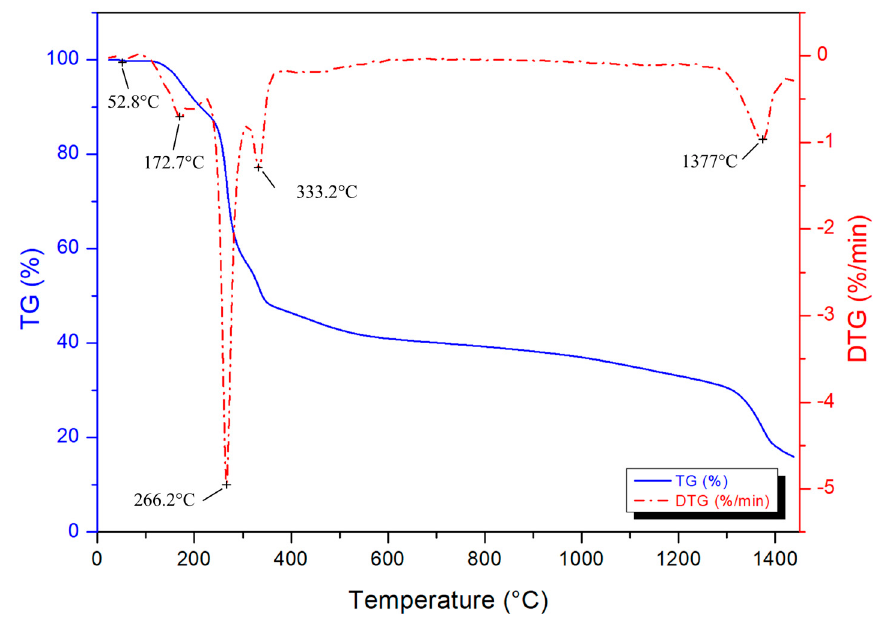
Figure 2. TG and DTG curves of the condensed gel.